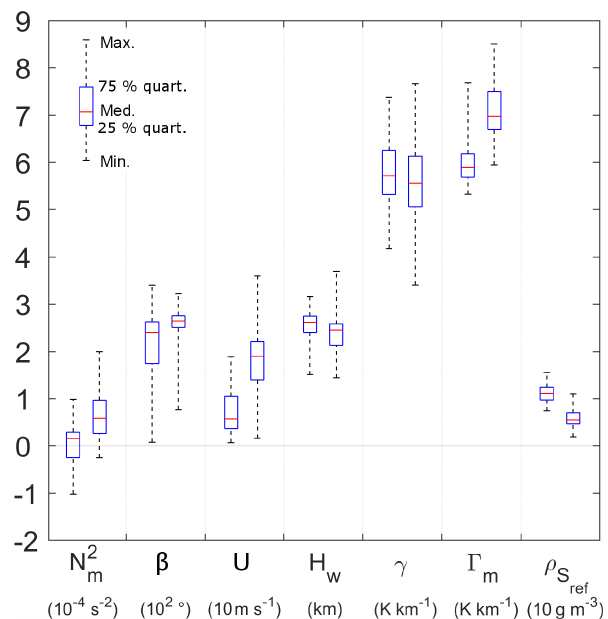
Figure 11. Atmospheric parameters required as input for the SPM2D derived from radio sounding observations at Stuttgart for the top200 events with mean, interquartile distance, minimum, and maximum values; the left whisker of each pair represents the sum- mer, and the right one represents the winter season. The units for each variable are given in the brackets below the variable